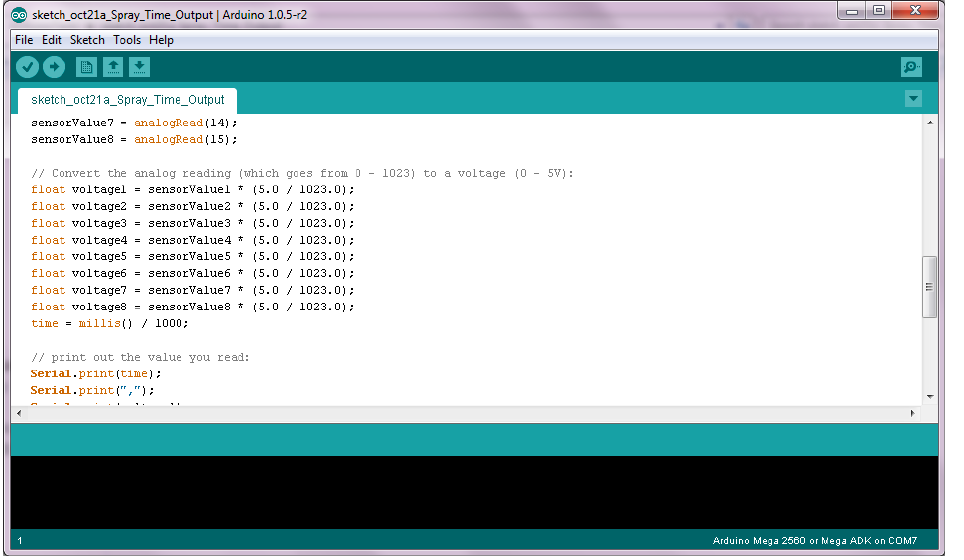
Figure 3. Screenshot showing a portion of the code programmed onto the DAQ board for reading analog voltages and serial string conversion and transmission.